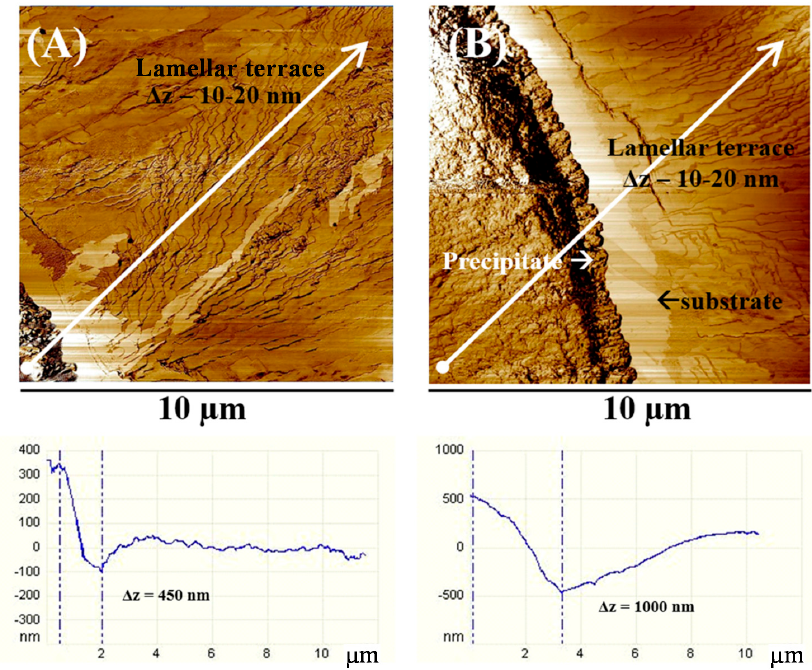
Figure 7. AFM phase images and height profiles on inter-band defects in extinction bands of the P12T thin film crystallized at T c = 110 °C, film thickness: ( A ) ~1.5 and ( B ) 3.5 µm, respectively.